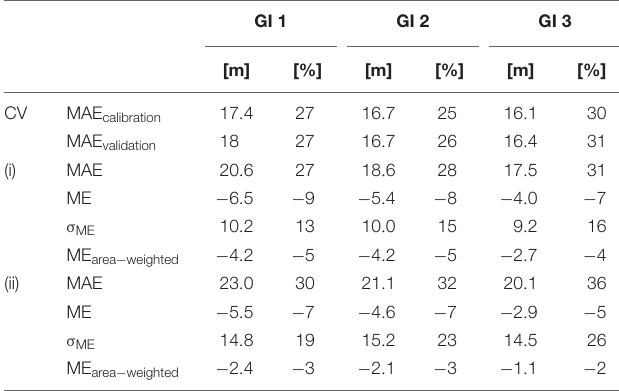
TABLE 2 | Results of the cross-validation (CV) showing the median of the mean absolute error (MAE) from calibration and validation sets for all calibration glaciers from the three glacier inventories (GI).